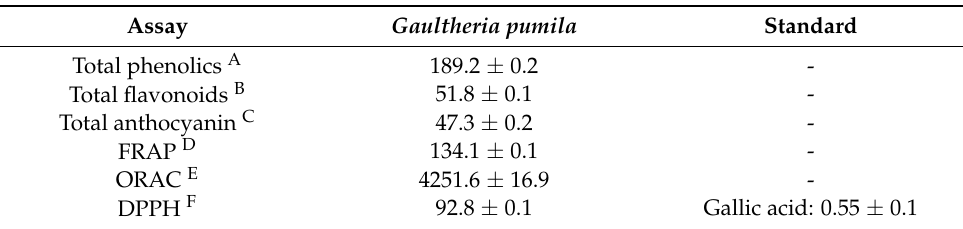
Table 2. Total phenolic, flavonoid, and anthocyanin content, and antioxidant activity of Gaultheria pumila berries.